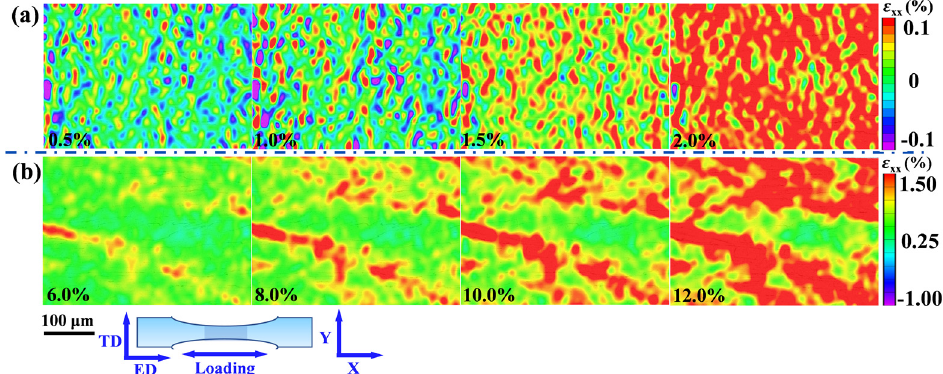
Figure 11. Strain evolution ε xx (parallel to the tensile direction) of hot-extruded laminated 0.5 wt.% CNTs/Mg composite. ( a ) Low strain range; ( b ) High strain range.